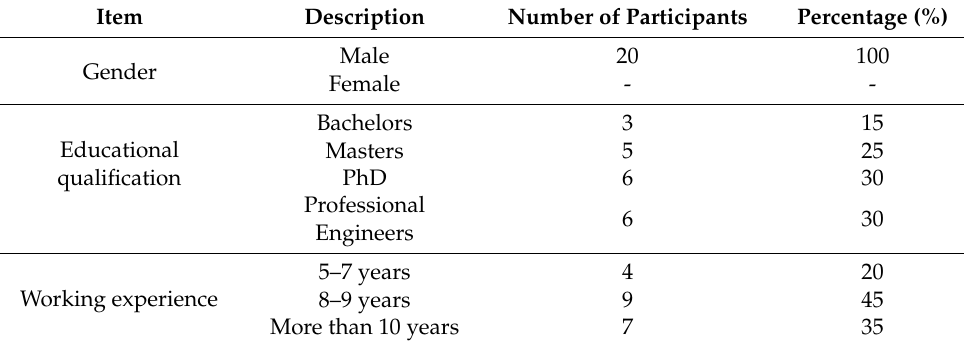
Table 2. Participant demographics ( n =